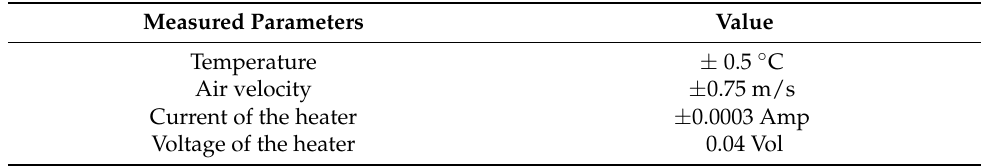
Figure 5. Confirmation of friction factor for plain heat exchanger. 5.2. Impact of Combined Basket–Twisted Tape Inserts Figure 6 depicts the impact of the basket and combination basket–twisted tape inserts on heat transfer rate. The average Nu and Re numbers were noted to be directly related to each other. This might be related as the turbulence intensity goes up with rising Re , which resulted in an increase in convective heat transfer. The use of basket turbulators alone resulted in a considerable increase in heat transmission rate with variation in Re. The av- erage Nu of the basket turbulators was found to be around 131.8 percent greater than that of the ordinary heat exchanger for constant pitch ratio (PR = 150 mm). The reason for this might be related to the heat exchanger creating a spiral or secondary flow with relatively high turbulent intensity, which leads to the disruption and reintegration of the thermal boundary layer, which further improves the convection heat transfer and momentum pro- cess. Using twisted-tape in combination with basket turbulators results in stronger swirl flow around the core region and more mixing occurring within the heat exchanger core and the wall region, which is why the average Nu is higher than that of basket turbulators